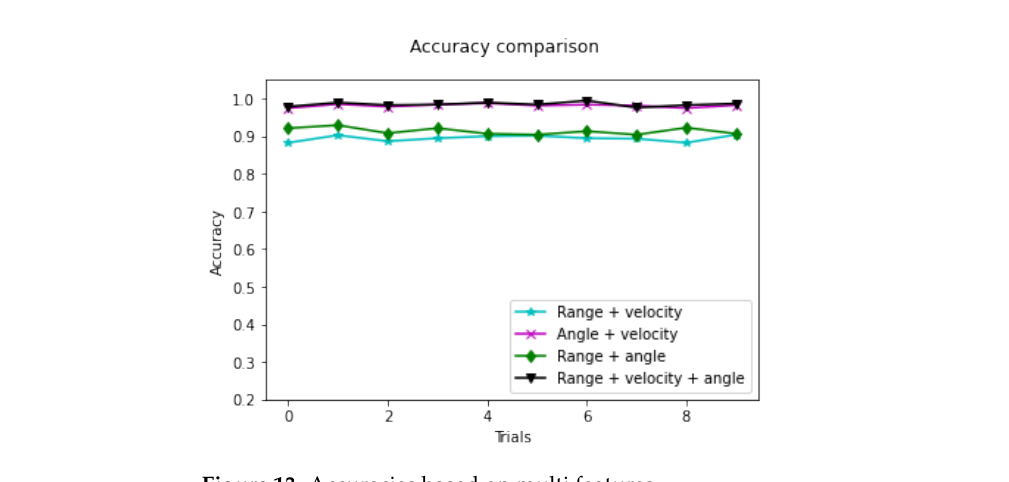
Figure 13. Accuracies based on multi features. Table 3. Comparison of accuracy based on feature combination.